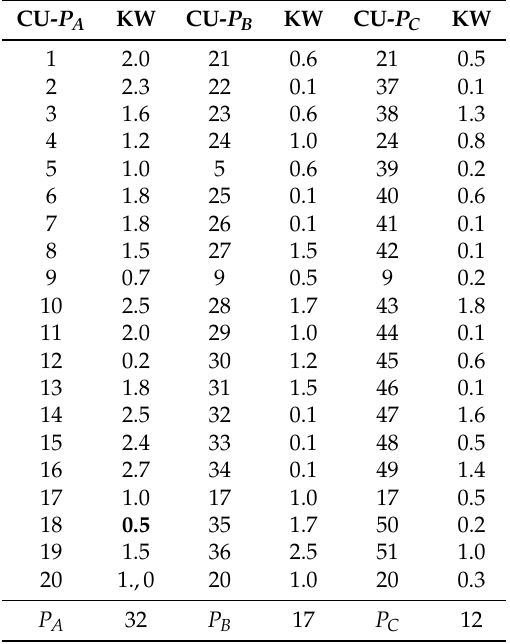
Table 4. Load Consumption Data in a LV grid.